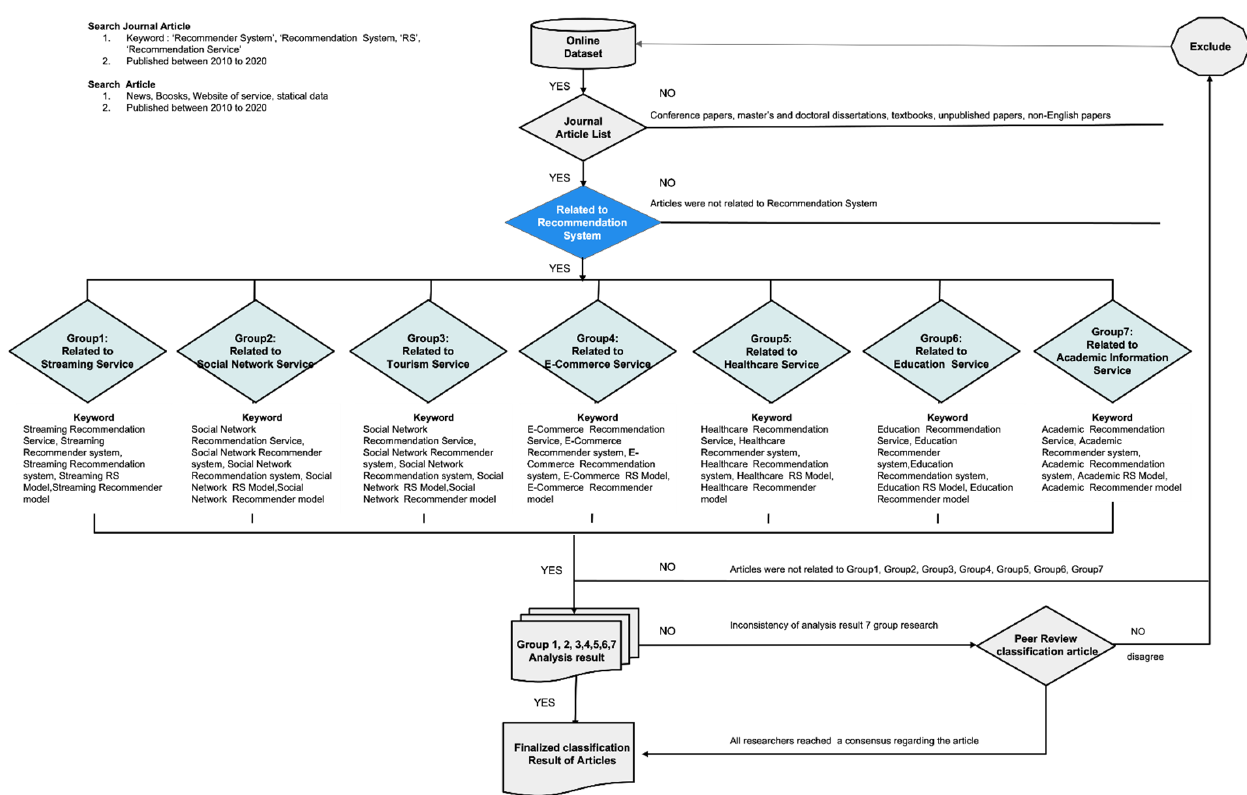
Figure 2. Process of analyzing recommended service area research and business size of representative service for each service field.